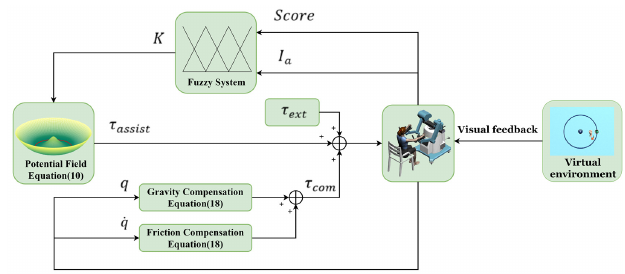
ure 9. The simplified control block diagram of FAP proposed in this paper is shown in Fig- Figure 9. ure 9.